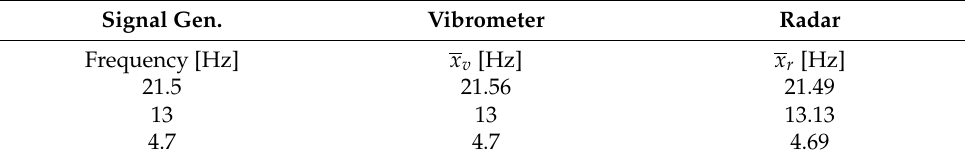
Table 4. Measurement results of the target frequency obtained in the first setup. Signal